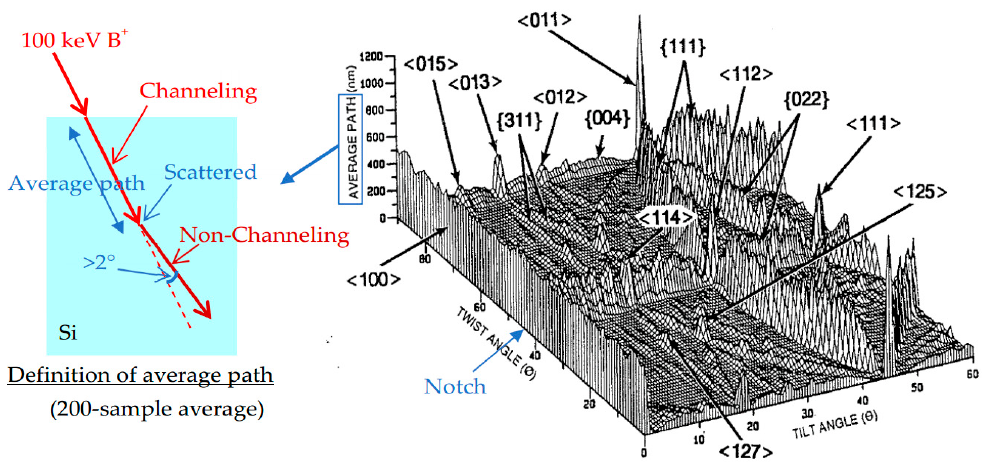
Figure 16. Average path dependence on the tilt and twist angles by Monte Carlo simulation [27–29]. The mean path is the distance along the ion trajectory until its direction deviates by more than 2° from the initial incident direction. Ion: B + , Energy: 100 keV, Tilt pitch: 1°, Twist pitch: 2°, Number of average: 200. The notch position is at twist =45°.